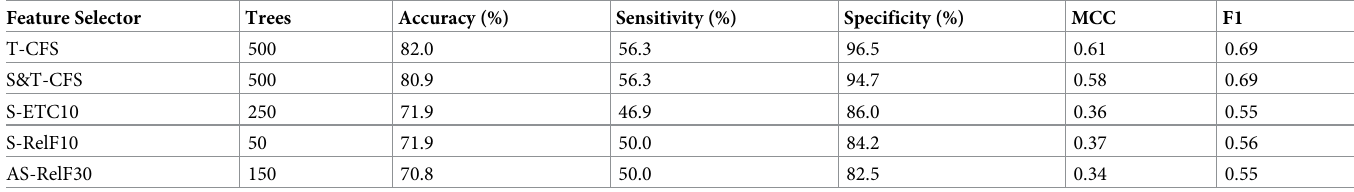
Table 5. Summary of tree optimizations for the 5 best models. Feature